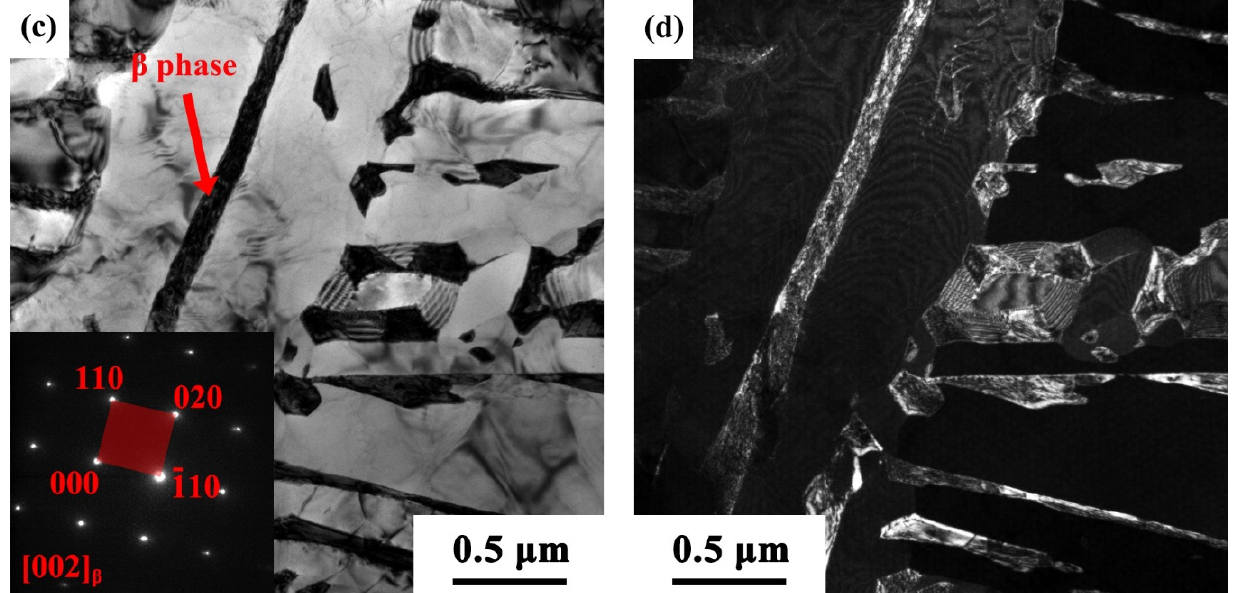
Figure 5. Bright-field TEM images showing the microstructure of Ti-6Al-4V alloy samples made with EBM ( a – c ), where the inserted SADP in ( b ) corresponds to the yellow-arrowed region, ( c ) β -phase in a bright-field TEM image and its corresponding SADP, and ( d ) dark-field TEM image of ( c ), where the β -phase becomes white.